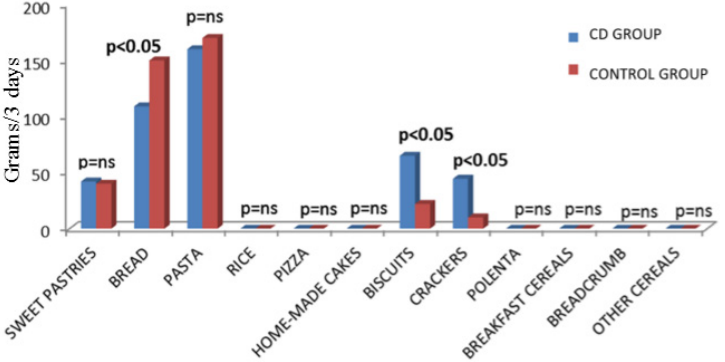
Figure 1. Median three-day consumption of cereal-based products in 82 celiac patients and 77 healthy controls. Data are expressed in grams.